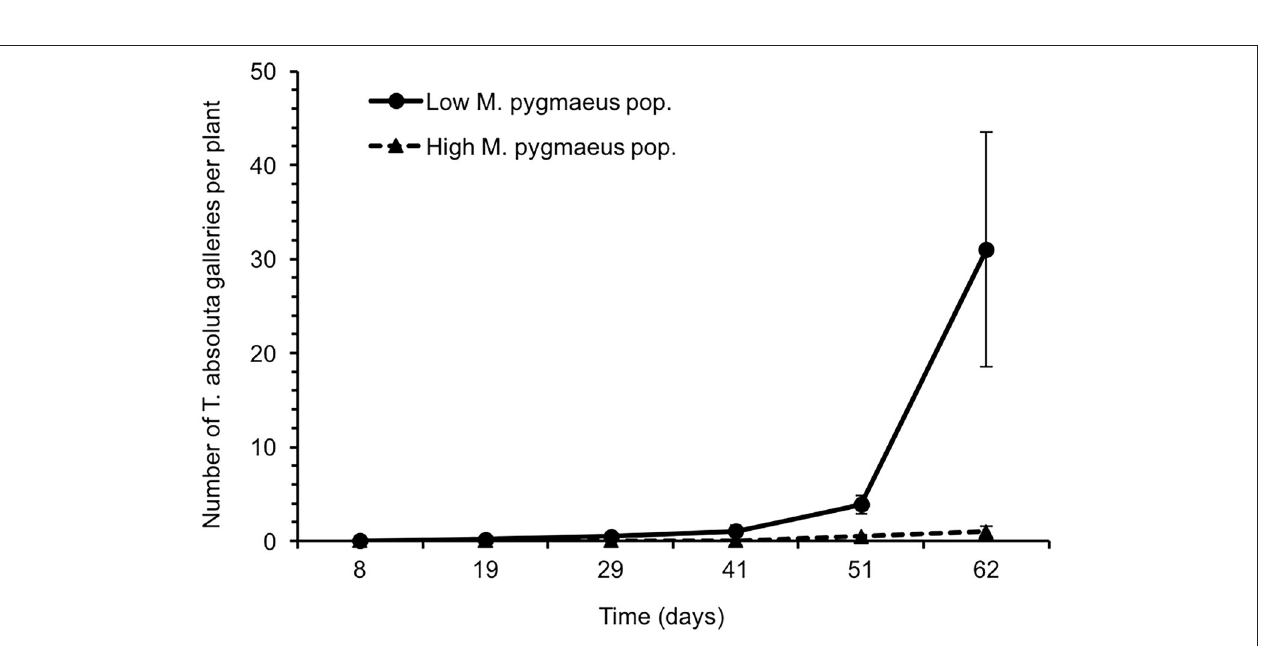
Frontiers in Ecology and Evolution |